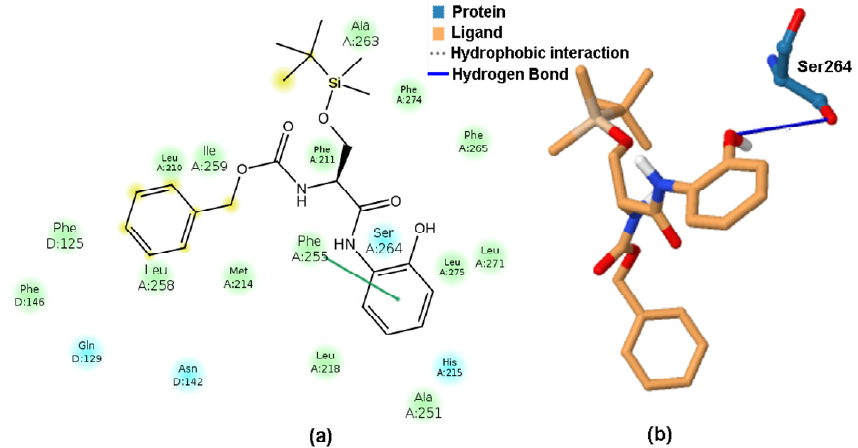
Figure 12. 2D-based and 3D-based interacting modes for the most potent PET inhibitor (molecule 2 ) produced by Maestro ( a ) and PLIP ( b )